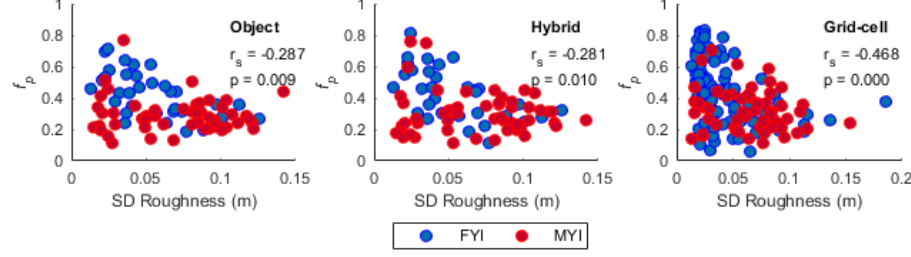
Figure 9. Scatter plots of f p as a function of standard deviation of roughness at the medium scale using object ( left ), hybrid object ( middle ) and 240 m grid-cell ( right ) aggregation approaches. Spearman correlation coefficients (r s ) and corresponding p -values are shown for pooled FYI and MYI data.